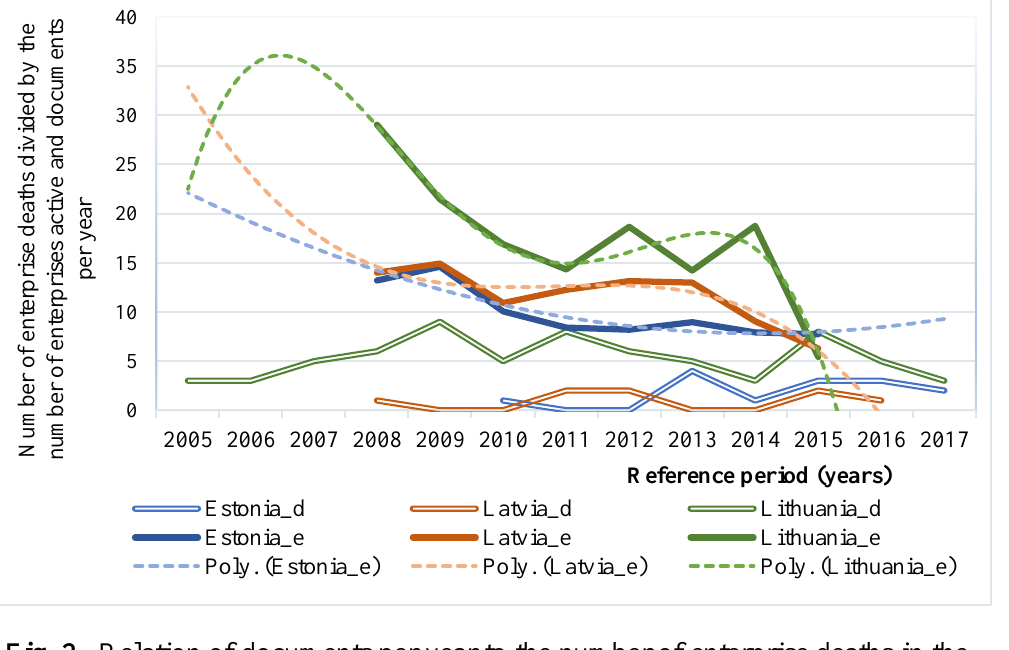
Fig. 2. Relation of documents per year to the number of enterprise deaths in the reference period divided by the number of enterprises active in 2005–2017 (Eurostat,